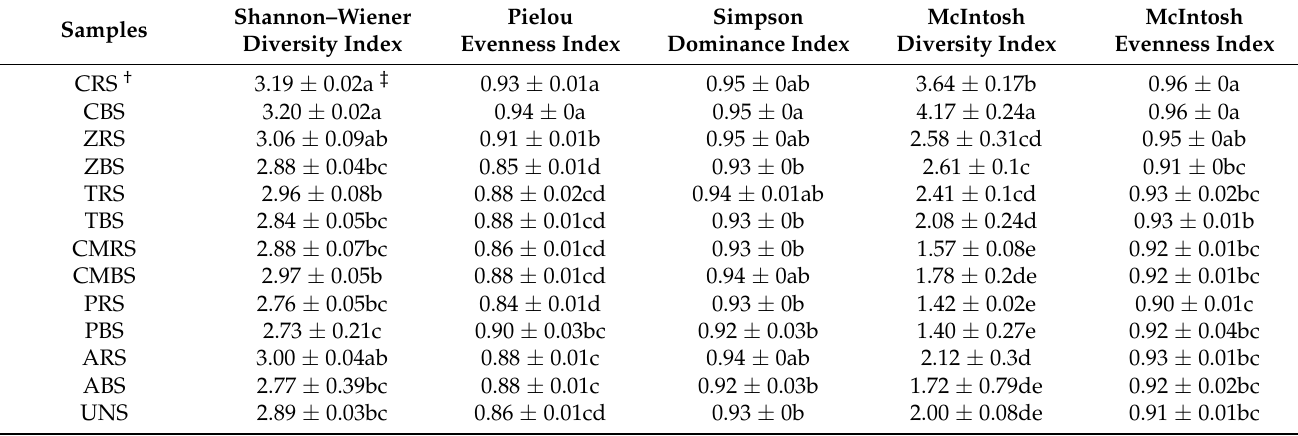
Table 2. Soil microbial functional diversity